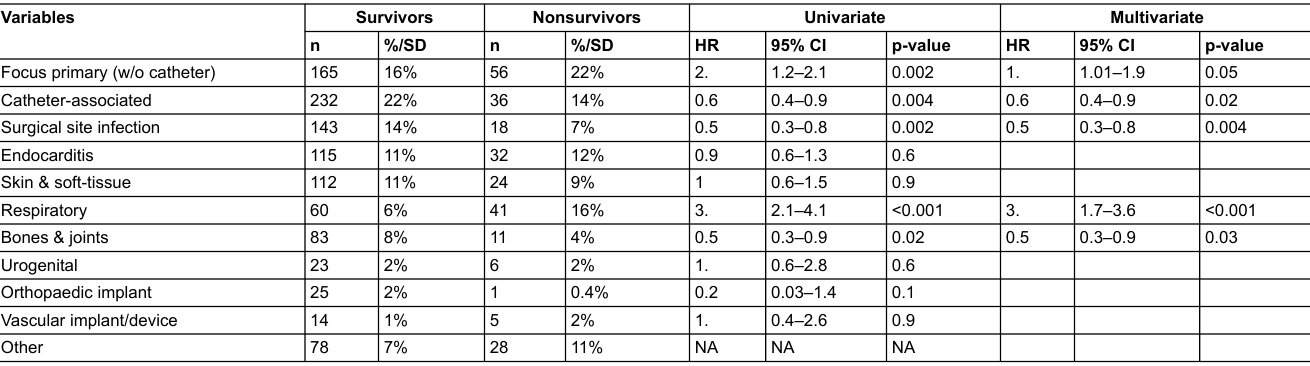
Table 2b: Uni- and multivariate analysis of infection foci for